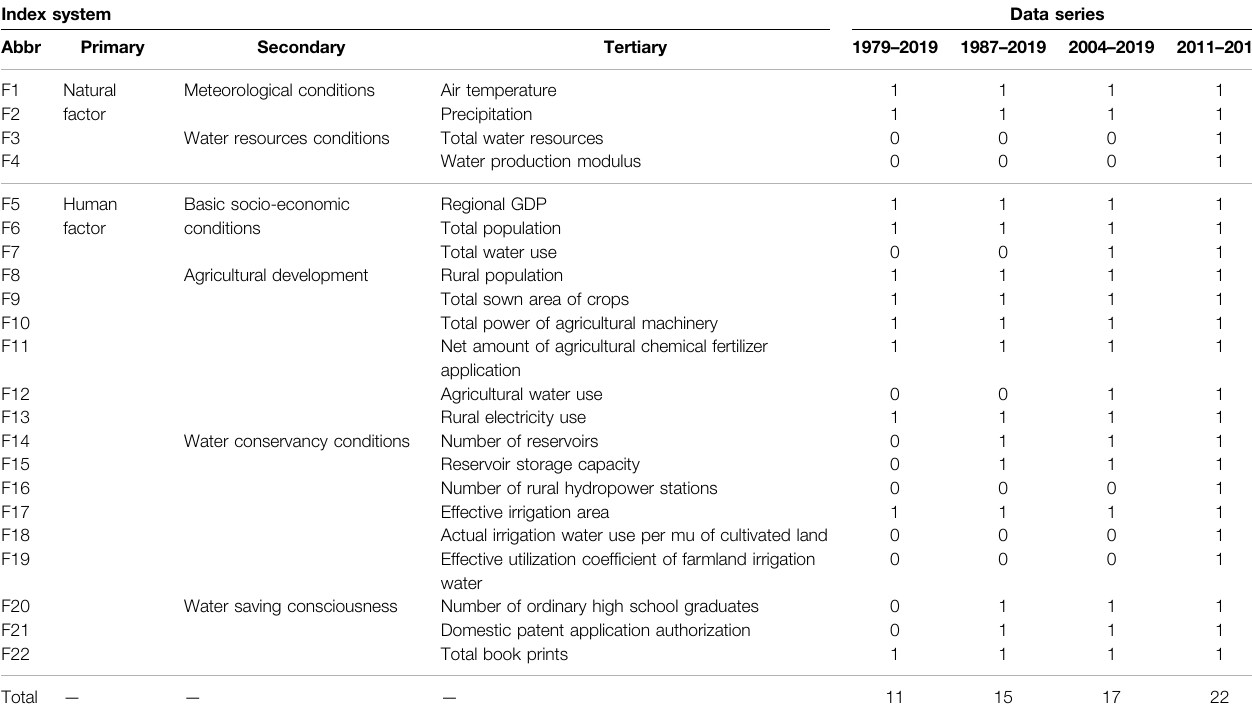
TABLE 4 | Index system of in fl uencing factors of agricultural drought disasters Index